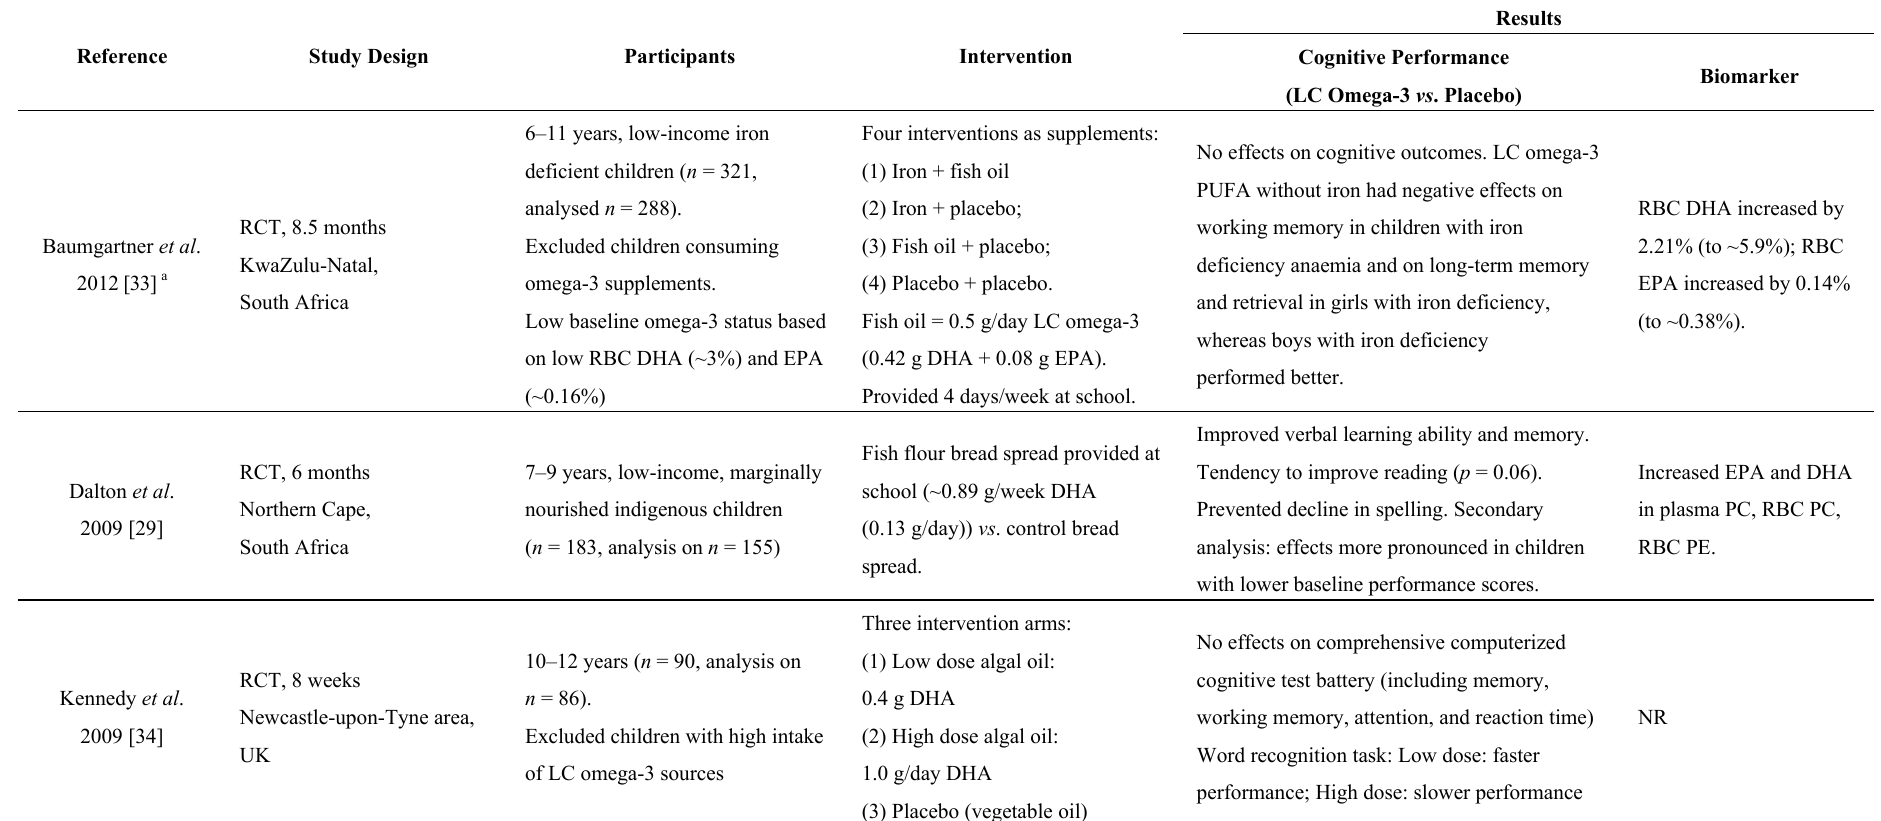
Table 1. Nutrition intervention trials of long-chain omega-3 PUFA and cognitive function, learning and school achievement in healthy school-aged